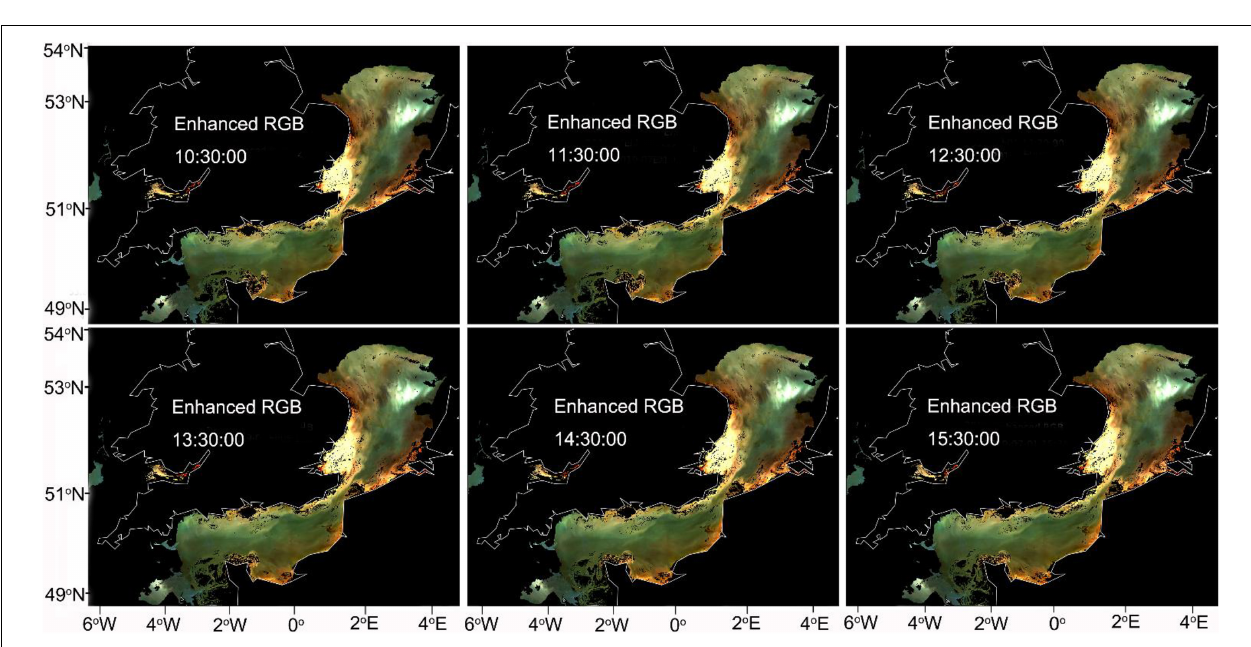
FIGURE 10 | Frames of predicted enhanced ocean-color RGB in the English Channel with high spatial resolution (100 m) showing more details of water properties including the movement of a bright coccolithophore bloom near 53 ◦ N (animation: